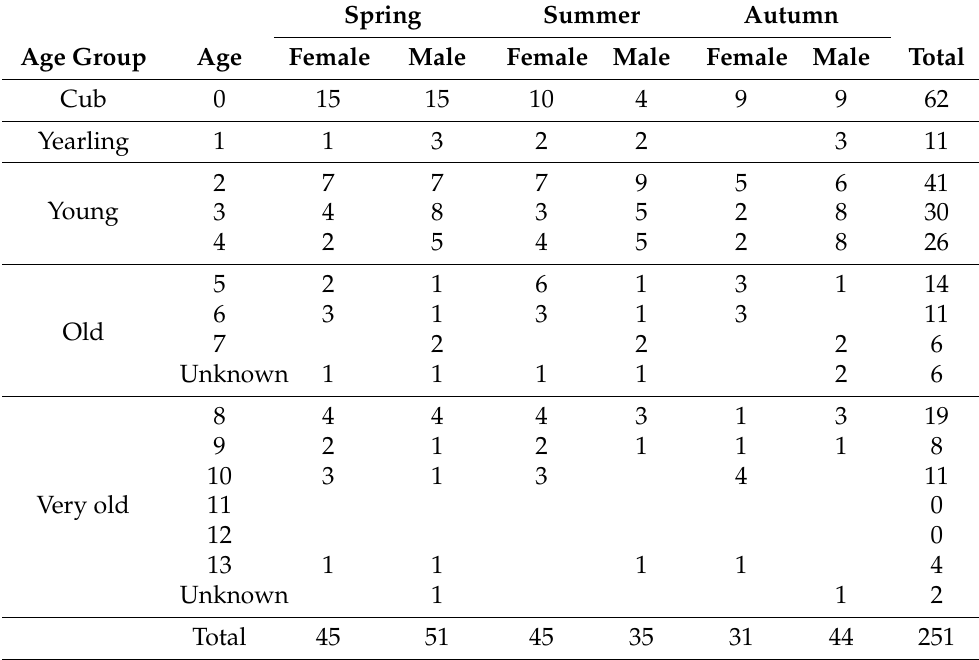
Table 1. Summary of sampling effort (badgers with unknown age were assigned to age group by tooth wear according to the method described by Bright Ross et al.